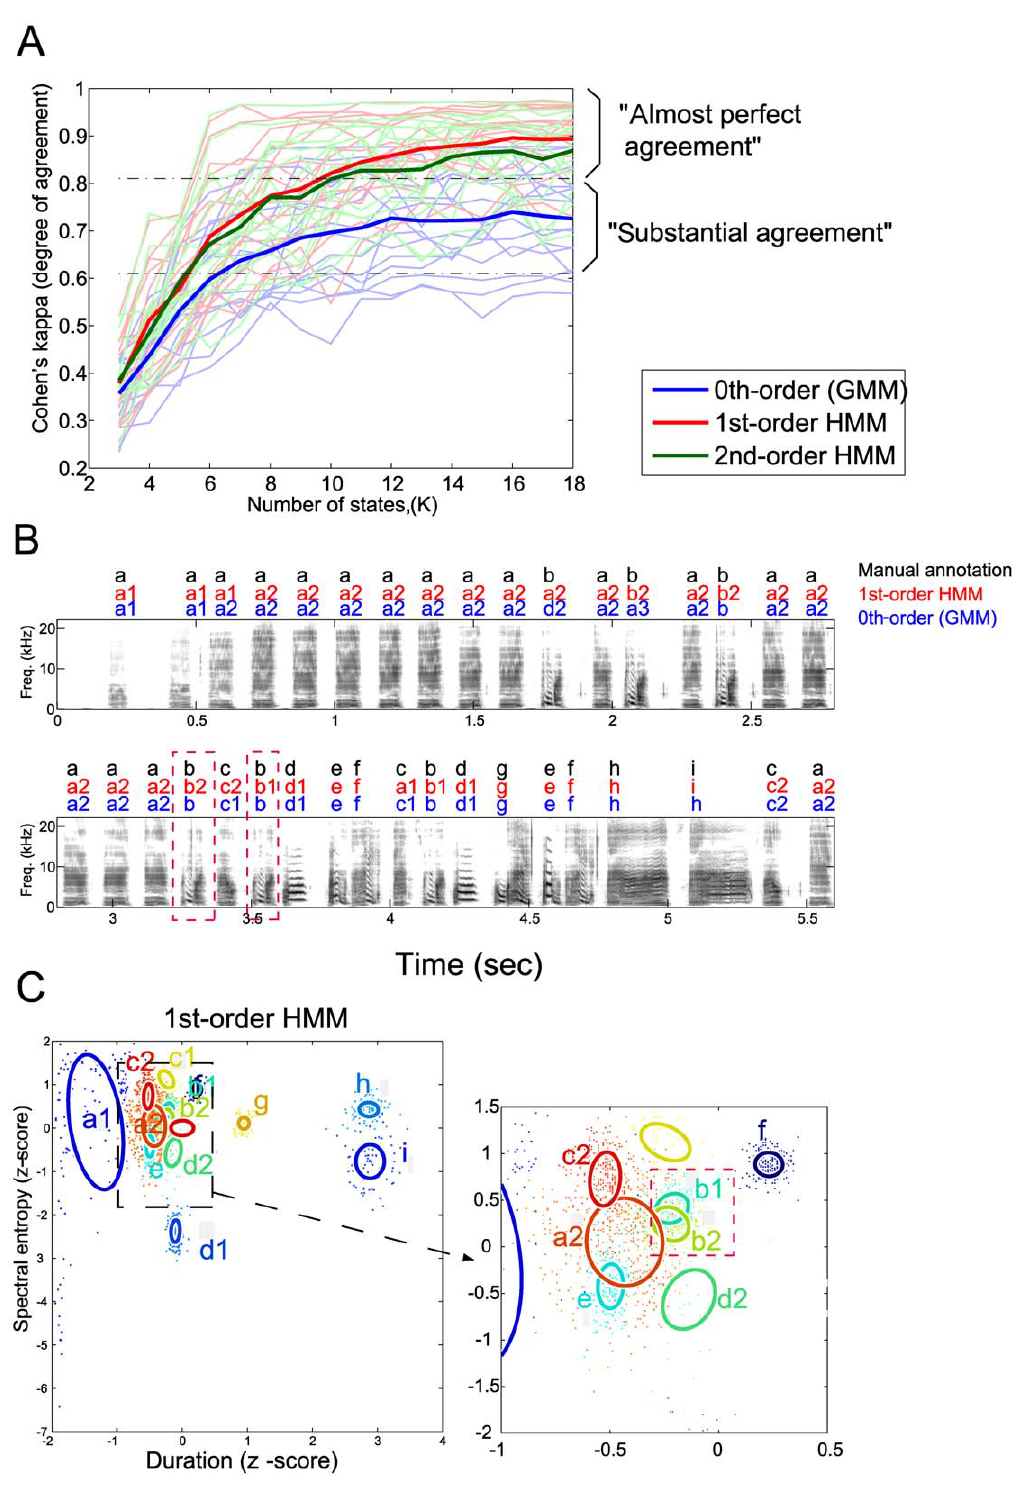
Figure 3. Comparison of annotation results using various models and human experts. (A) Kappa’s coefficients, which are measure for agreement between model annotations and manual annotation by human experts, are functions of number of states, K . Thin lines represent results for individual birds, and thick lines represent average for each model order. (B) Example of annotations for song of BF09. Black labels represent manual annotations done by visual inspection of sonograms. Red and blue labels are labeled using Gaussian mixture model (zeroth-order model) with K ~ 13 and first-order HMM with K ~ 18 , respectively. Number of states ( K ) that gives the highest lower-bound on log marginal likelihood were used. (C) Example of model fitting results on sound feature space (duration and spectral entropy) for same song as (B). Results from first-order HMM. Ellipses represent contour of Gaussian distribution of each state, and letters indicate syllable aligned to state.